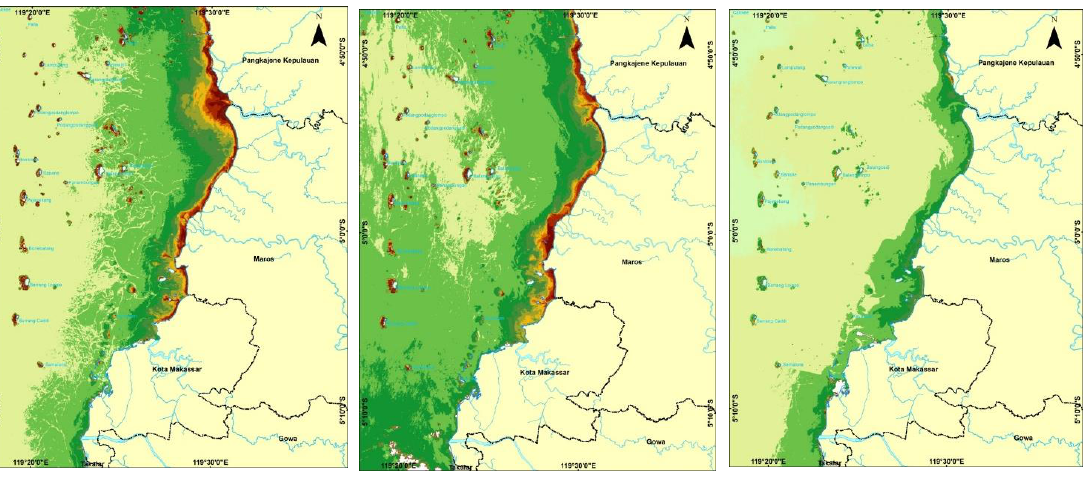
Figure 9. TSS distribution around Bontosua and Ballang Caddi island and near from the main land and shore lines in Spermonde waters in the transition season from east to west season, (a) 2013, (b) 2016, (c)